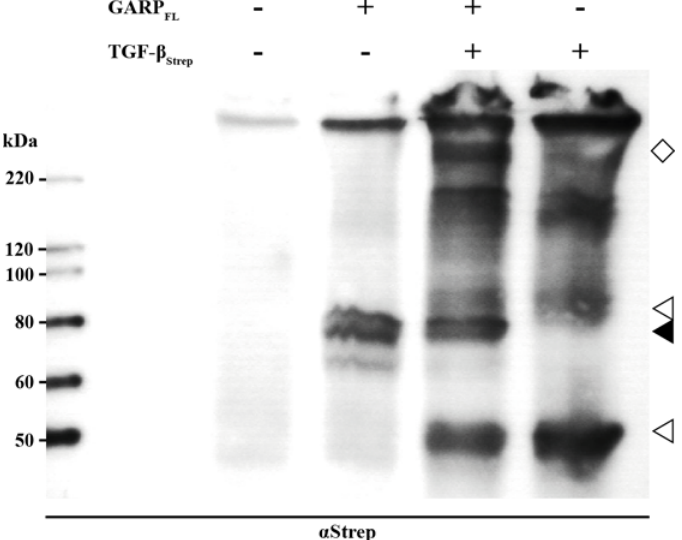
culture medium was exchanged for FCS-free DMEM supplemented with NEAA. Cell lysates were prepared using 200 μ l RIPA buffer per 1x10 6 cells. Samples were separated on a 10% PAA SDS-PAGE followed by western blotting on a PVDF membrane. For molecular size determination the magic mark XP marker (Invitrogen; Darmstadt, Germany) was used. For detection the blot was probed with anti-Strep-tag and anti- His-tag antibodies, respectively (Quiagen; Hilden, Germany). As secondary antibody a peroxidase coupled anti-mouse-IgG antibody (Dianova; Hamburg, Germany) was